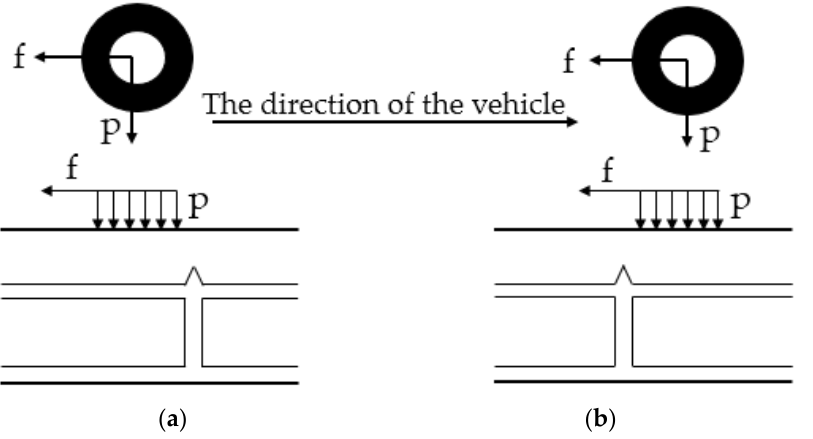
Figure 13. Schematic diagram of vehicle load action. ( a ) Approaching the crack; ( b ) away from the crack.